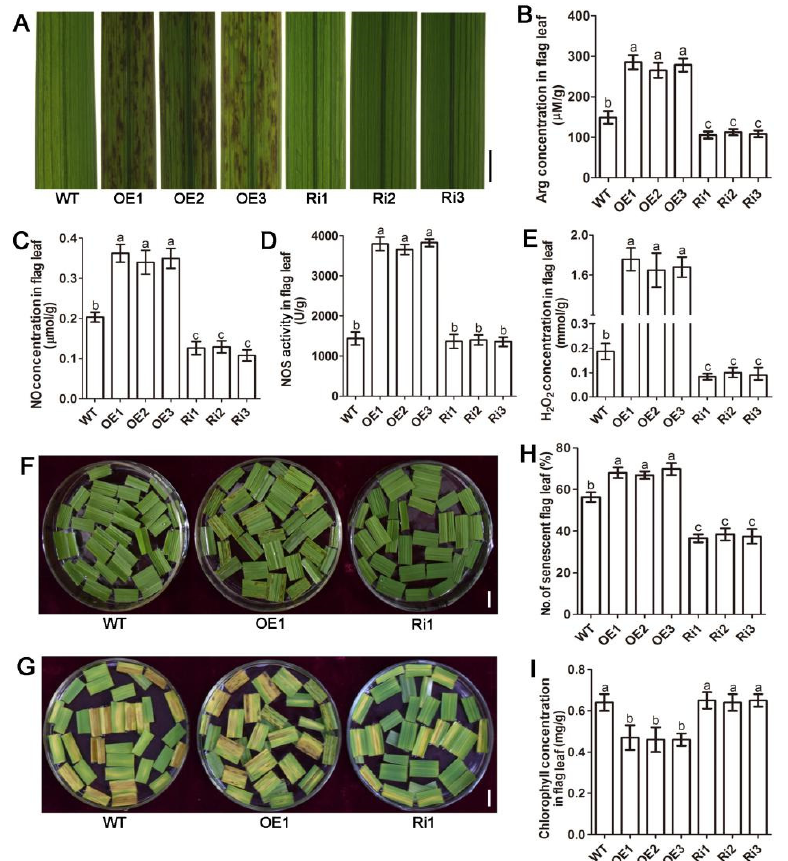
Figure 1. OsAAP3 leads to lesion mimic and leaf senescence in rice. Flag leaf phenotype ( A ), arginine (Arg) concentration ( B ), nitric oxide (NO) concentration ( C ), nitric oxide synthase (NOS) activity ( D ), and hydrogen peroxide (H 2 O 2 ) concentration ( E ) of the OsAAP3 overexpressing (OE) lines, RNA interference (Ri) lines, and wild-type (WT) at the heading stage. Flag leaf phenotype of the OsAAP3 OE lines, Ri lines, and WT with H 2 O ( F ) and H 2 O 2 ( G ) treatments for 4 d. The number of senescent yellow leaves ( H ) and chlorophyll concentration ( I ) for flag leaves of the OsAAP3 OE lines, Ri lines and WT with H 2 O 2 treatment for 4 d. The flag leaves was taken at 110 days after sowing. Scale bar =0.5 cm in A, F, G. The letters above the error bars are ranked by the Duncan test at p < 0.05. Values are means ± standard deviation ( n = 5).